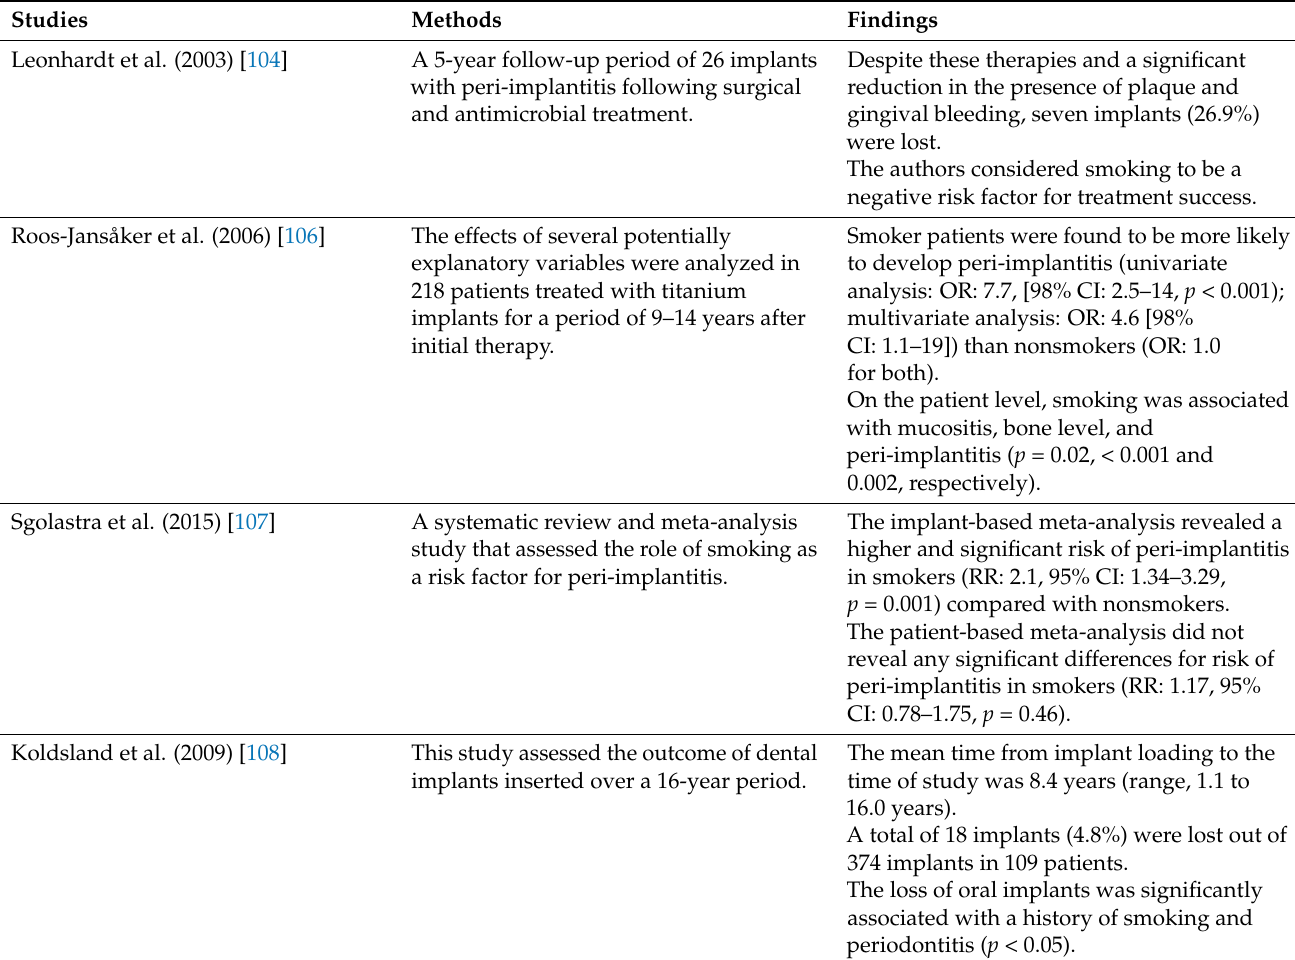
Table 2. Studies which have investigated the effect of smoking on